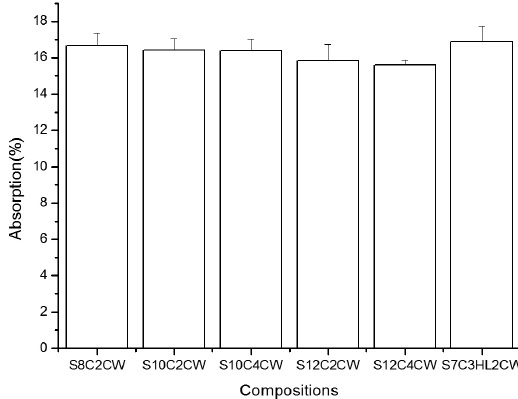
Figure 7. Water absorption values of soil-cement-lime and CW bricks.